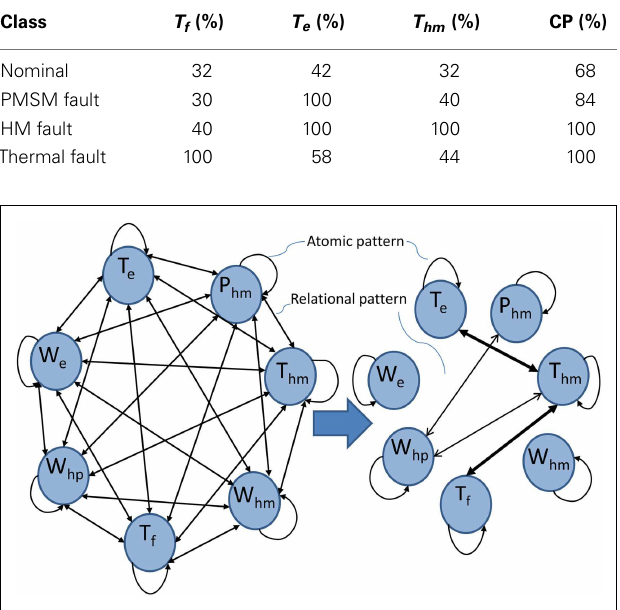
FIGURE 6 | Pruning of STPN (Left: complete STPN, Right: pruned STPN)